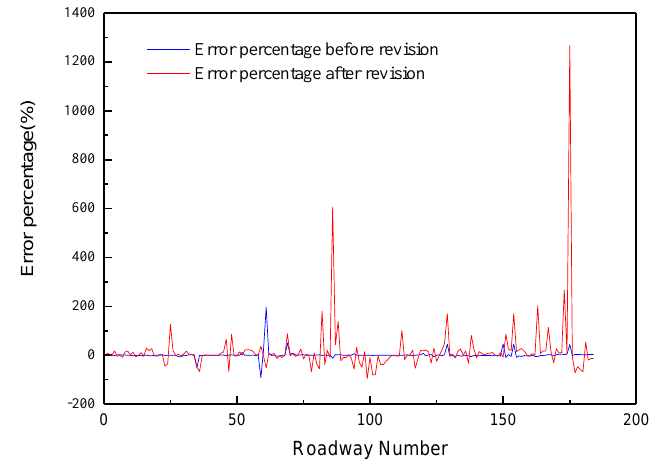
Figure 5. Error percentage of simulated airflow rate before and after revision. Table 1. Roadways with more than 10% airflow rate error.